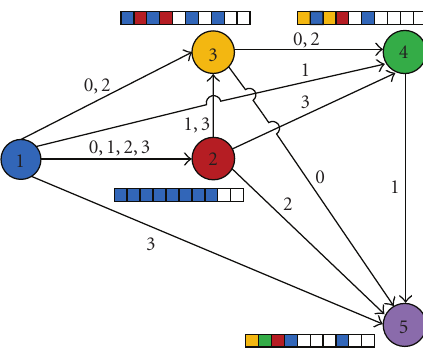
Figure 7: Partial RTP stream delivery.